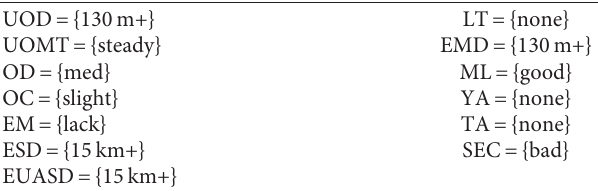
Table 5: Enter information.